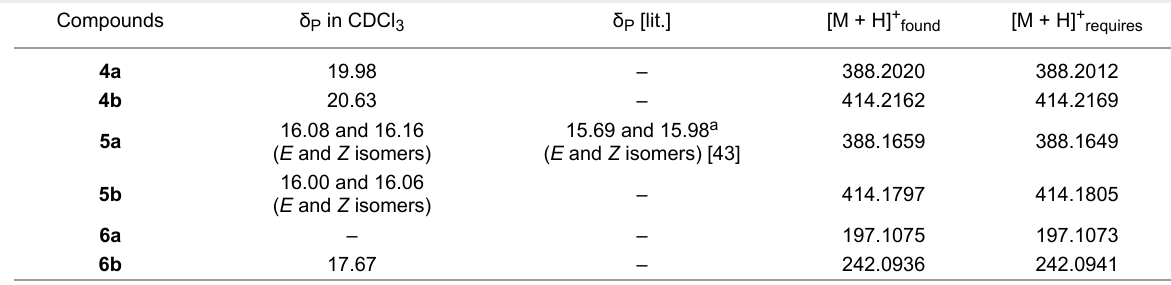
Table 4: Spectral characterization of N -ethyl- ( 4 ) and N -formyl- ( 5 ) (aminomethylene)bisphosphonates and imine-type intermediates 6a and 6b .